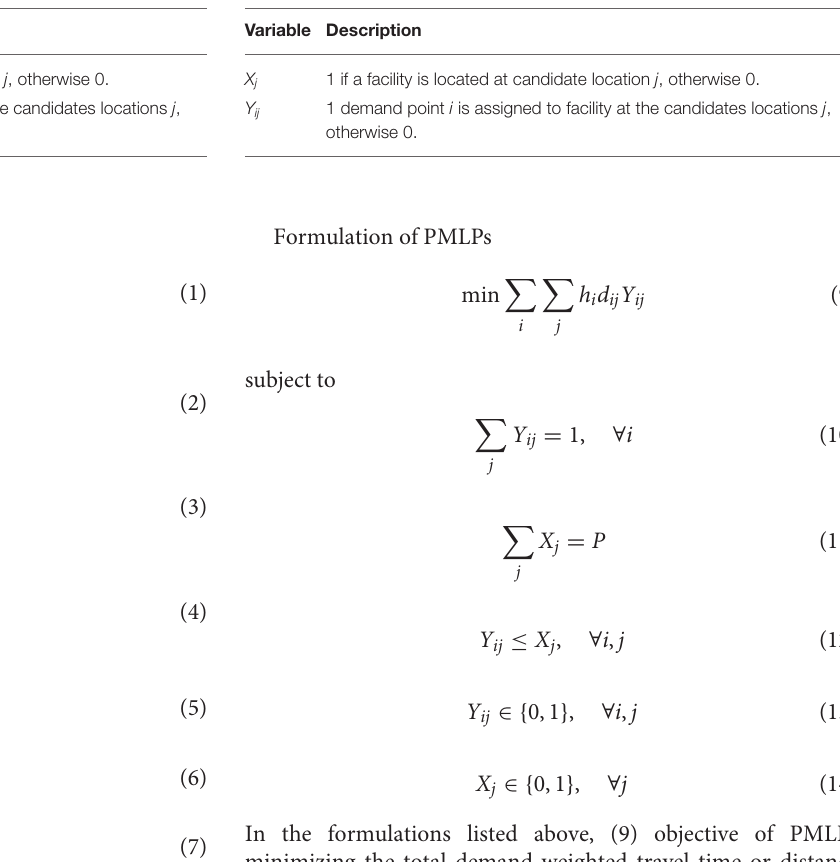
TABLE 3 | List of decision variables for PMLPs. TABLE 4 | List of decision variables for